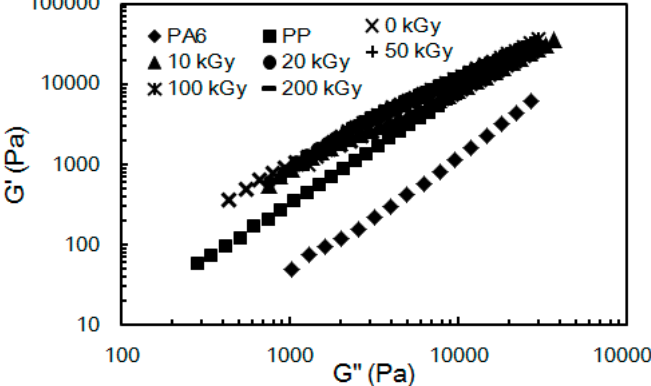
Figure 6. Plots of storage modulus (G’) against loss modulus (G”) for virgin PA6, PP, and PA6/PP (80/20) blends irradiated at different dosages.